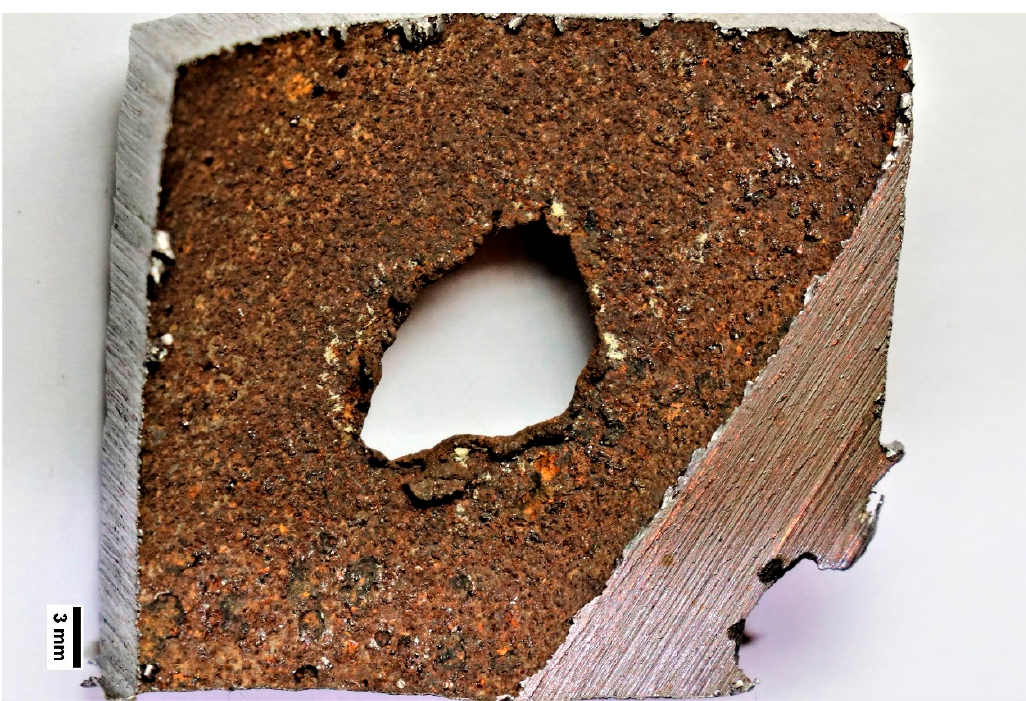
Figure 3. An inner surface of the failed elbows.